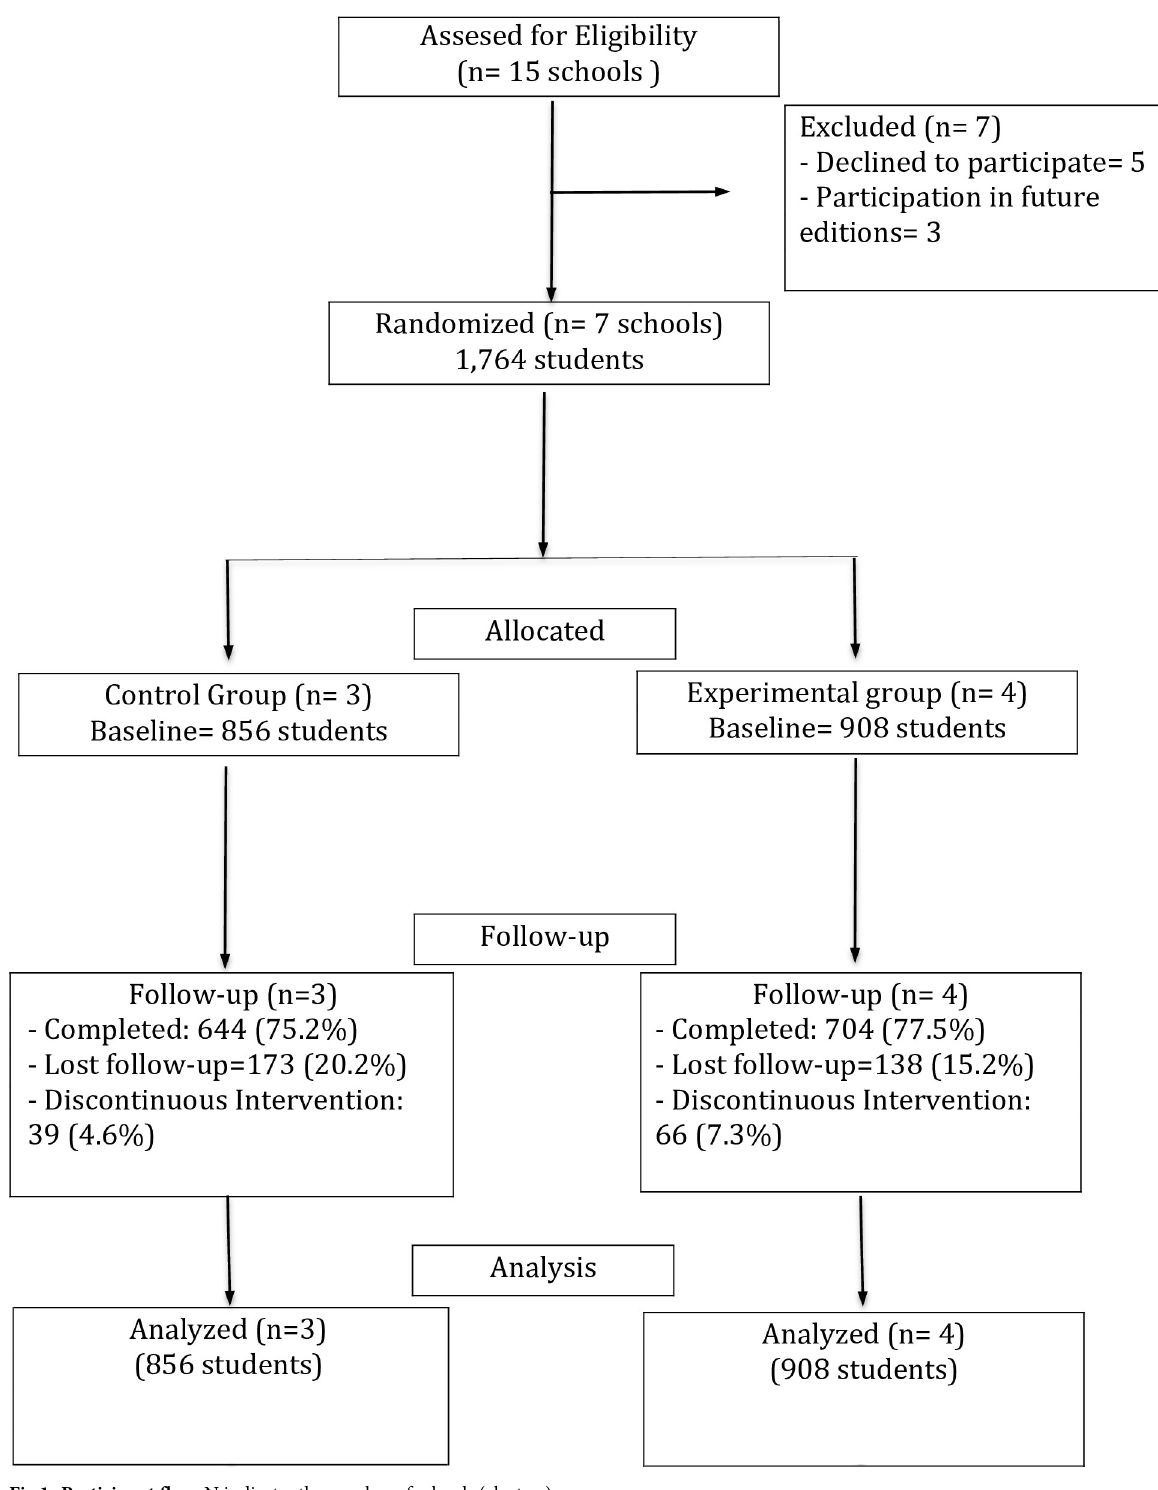
Fig 1. Participant flow. N indicates the number of schools (clusters).